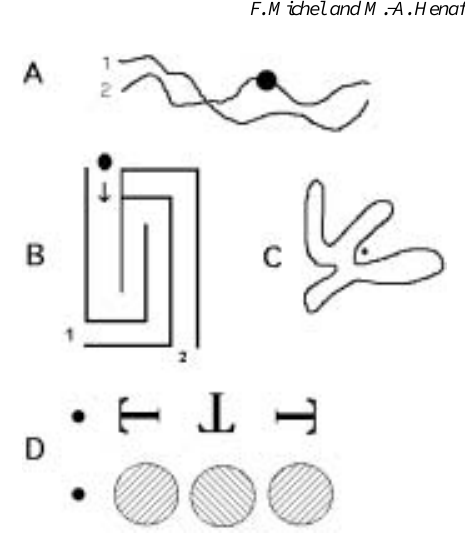
Fig. 4. Four tasks which require spatial attention: A- Deciding if the black point is on line 1 or line 2; B- Finding the exit of a maze; C- Deciding if the black point is inside or outside a complex shape; C- Judging the orientation of the middle letter or middle grid while fixating the black point.